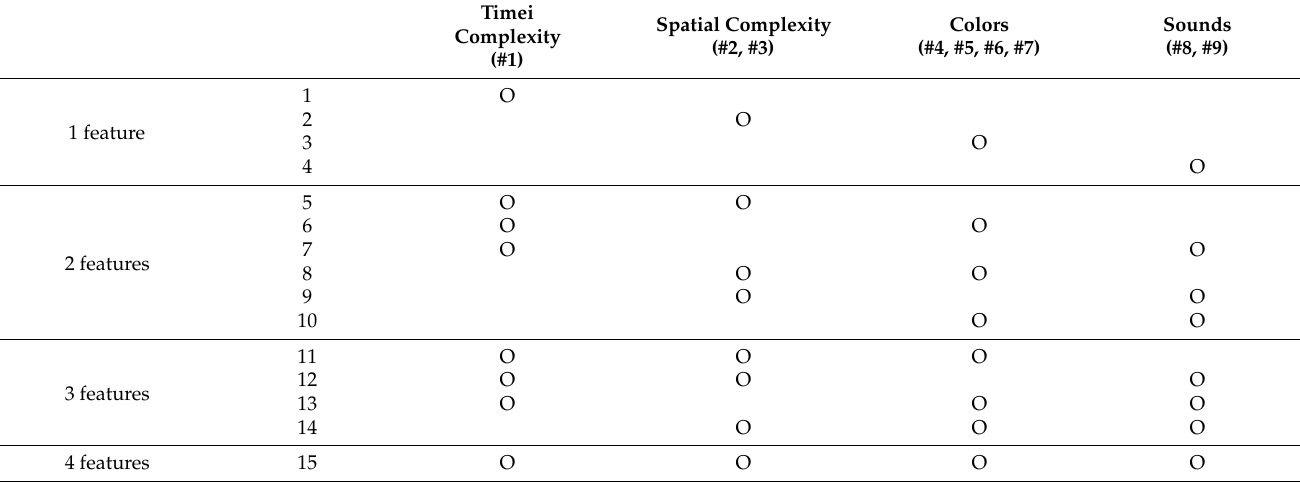
Table 1. The analyses for 15 combinations from single feature to multi